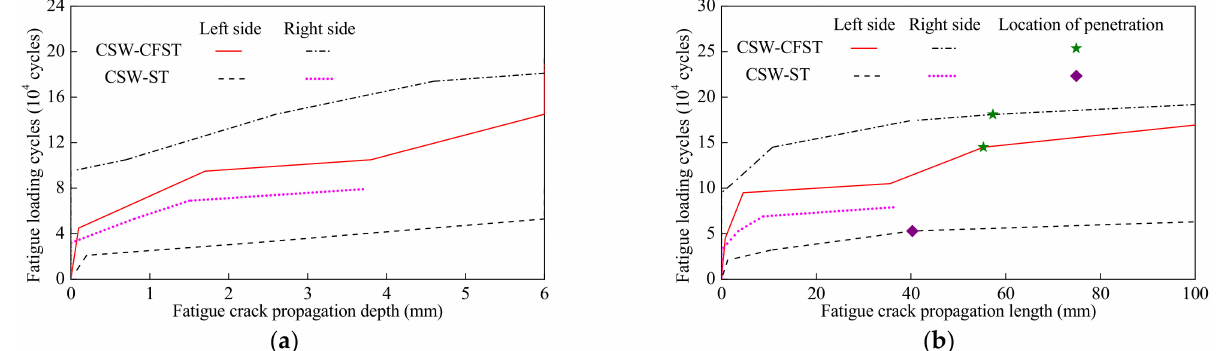
Figure 14. Comparison of fatigue crack propagation rates: ( a ) propagation depth-loading cycles curves; and ( b ) propagation length-loading cycles